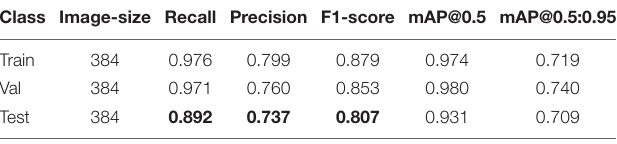
TABLE 3 | Classification model results of SP stage of lettuce based on YOLO-v5.